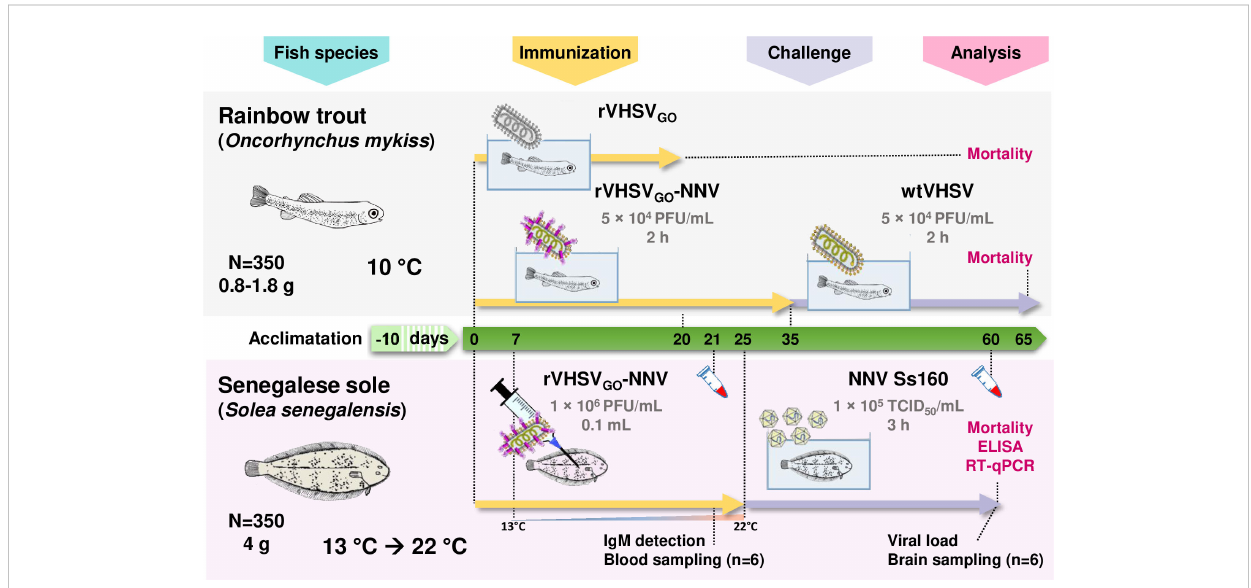
FIGURE 7 Experimental setup. Three different fi sh experiments were performed. The fi rst on trout was designed to test the attenuation provided by the gene order rearrangement of the VHSV genome. The second on trout was conducted to test the safety and the protective ef fi cacy of rVHSV GO -NNV against a lethal VHSV challenge. All trout infections were performed by bath immersion with a viral load of 5 × 10 4 PFU/mL in 3 L of water. The third was conducted on sole to test the safety, the immunogenicity and the protective ef fi cacy of rVHSV GO -NNV against a lethal NNV challenge. The immunizations and the lethal NNV challenge were performed by injecting 1 × 10 5 PFU of rVHSV GO -NNV per fi sh and bath immersion with 1 × 10 5